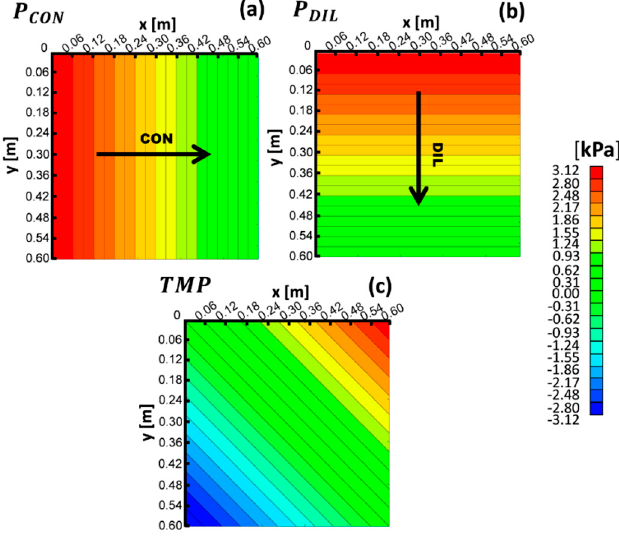
Figure 9. Results for a cross flow stack of 0.6 m sides at P in − P out = 3.12 kPa ( U s = 1 cm / s) in the absence of membrane deformation: relative pressure maps for the CON ( a ) and DIL ( b ) channels, and TMP ( c ).